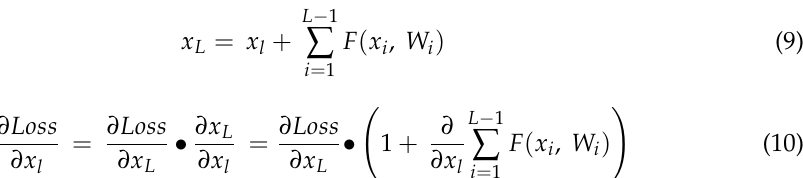
Figure 5. Operation declaration of squeeze-and-excitation networks.